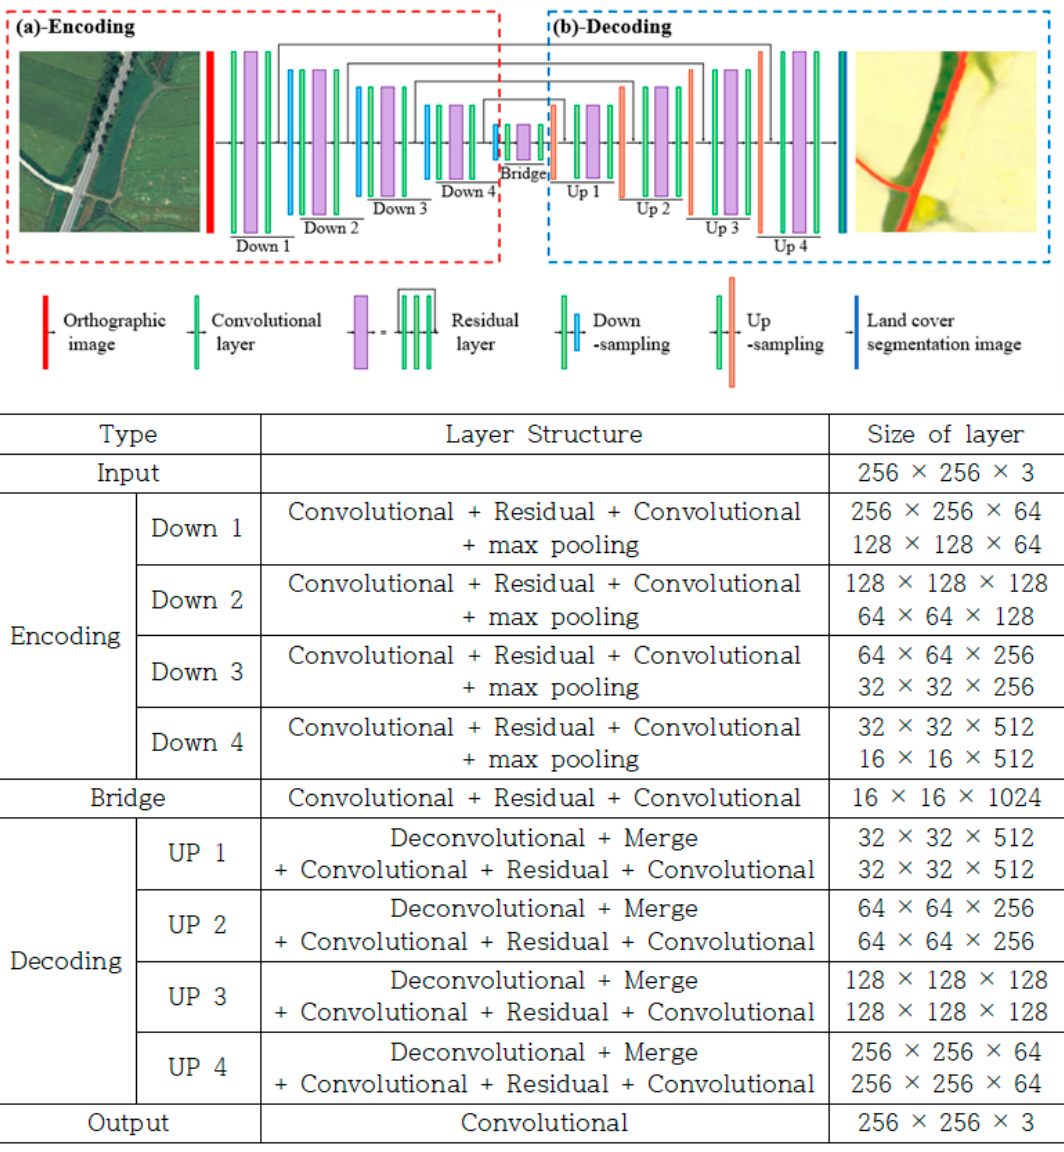
Figure 3. Architecture of the convolutional neural network (CNN)-based land cover classification module. ( a ) Encoding, ( b ) Decoding.